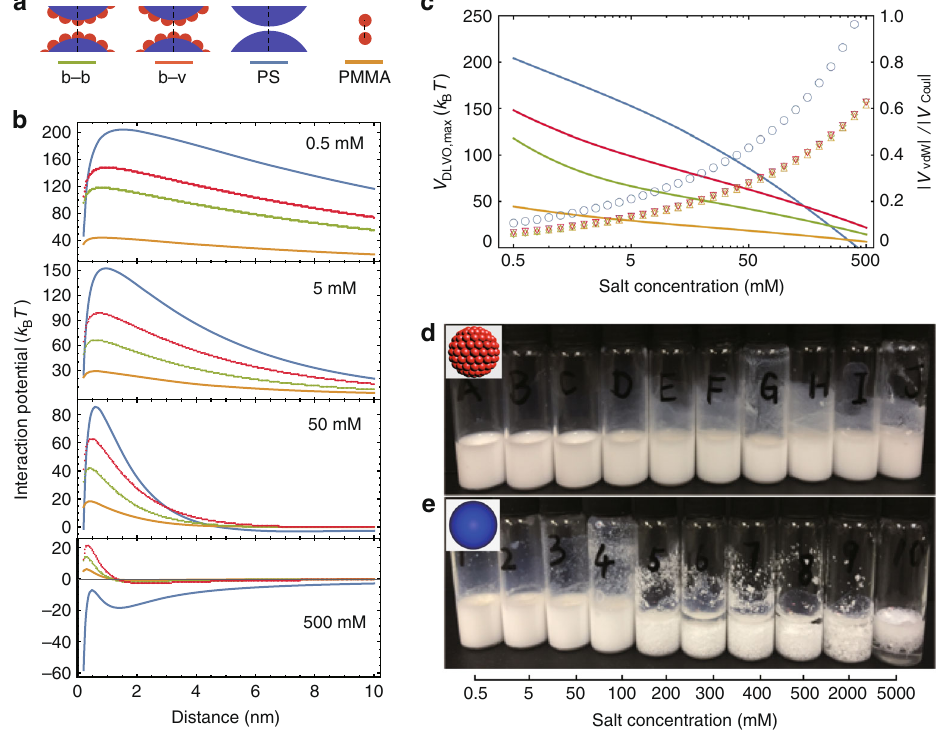
Fig. 5 DLVO calculation and colloidal stability in varying salt concentrations. a Possible contact geometries between raspberry particles (bump-to-bump (b – b, green lines) and bump-to-valley (b – v, red lines)), smooth PS (blue lines) and nanoscale PMMA particles (yellow lines). b Interaction potentials V DLVO for raspberry, smooth PS and nanoscale PMMA particles (same colour scheme as in a ) for 0.5, 5, 50 and 500 mM added NaCl. c Primary energy maximum V DLVO,max (solid lines) and relative strength of attractive interactions to repulsive forces ( and b – v (inverted triangles)), smooth particles (circles) and nanoscale PMMA particles (triangles) against salt concentration. d , e Photographs of dispersions of raspberry particles and smooth particles, respectively, at different added NaCl